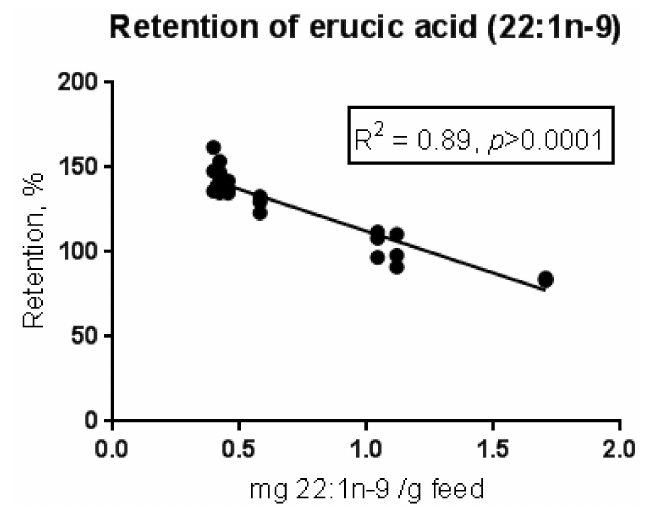
Figure 2. Retention (the amount of erucic acid accumulated in the fish during the feeding period in percentage of the amount eaten) of erucic acid in whole fish in relation to dietary content of erucic acid, in a feeding trial with Atlantic salmon [10] given eight experimental feeds ranging from 40–170 mg erucic acid/100 g feed. The adjusted R -value and the p -value for a linear regression model are given.